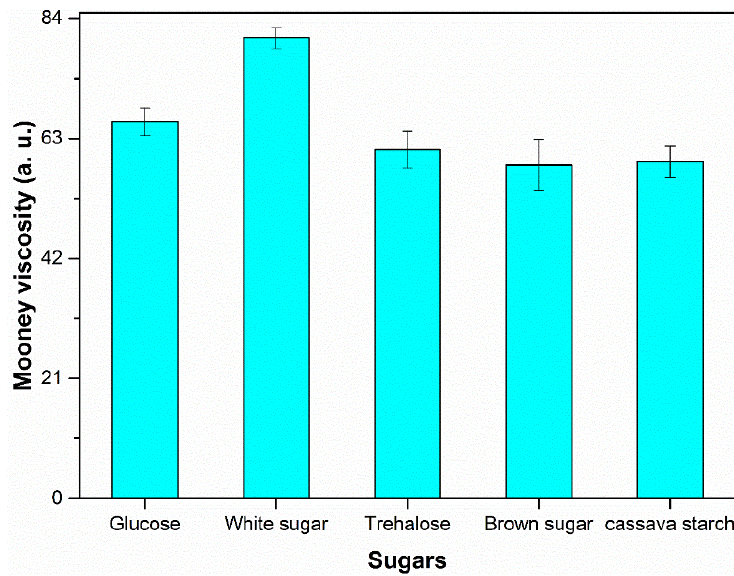
Figure 5. Effect of different sugars on Mooney viscosity of NR samples.